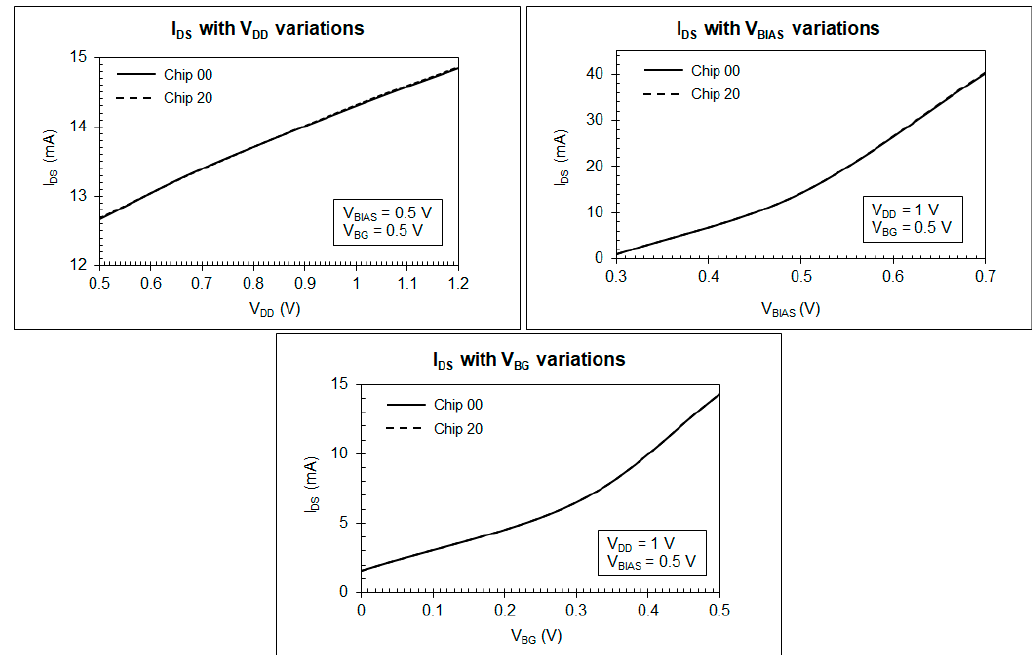
Figure 10. ( a ) Measurement setup; and ( b ) probing situation of the proposed CMOS PA IC.